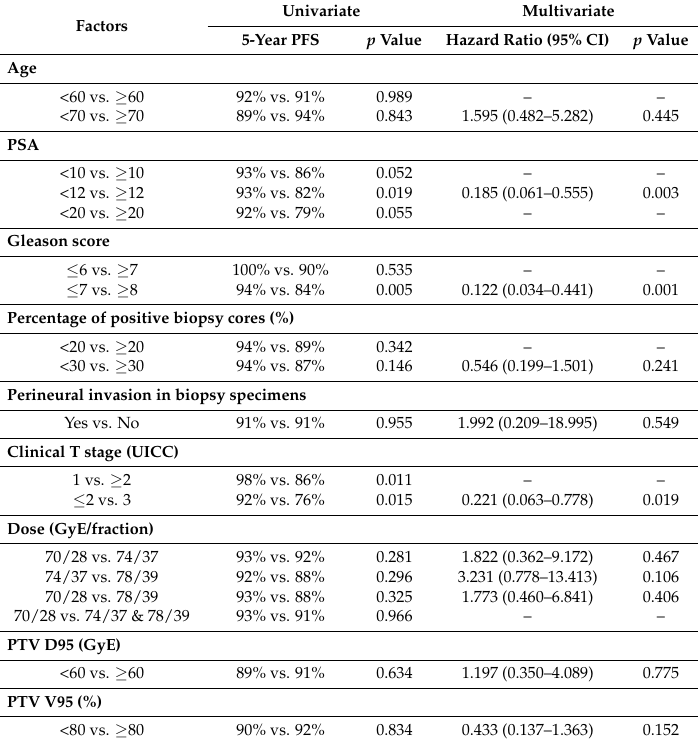
Table 2. Univariate and multivariate analysis for